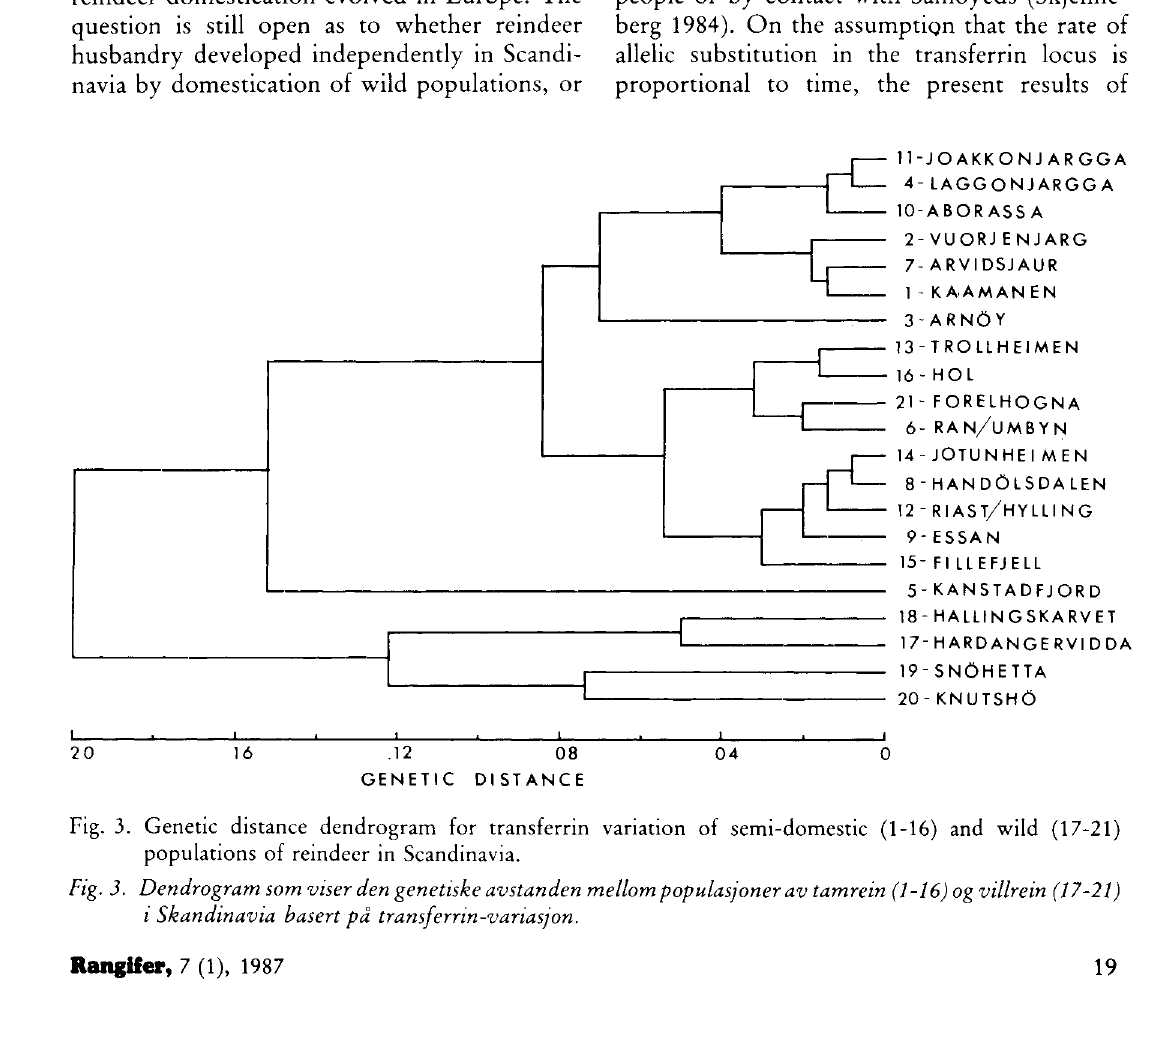
Fig. 3. Genetic distance dendrogram for transferrin variation of semi-domestic (1-16) and wild (17-21) populations of reindeer in Scandinavia. Fig. 3. Dendrogram som viser den genetiske avstanden mellom populasjoner av tamrein (1-16) og villrein (17-21) i Skandinavia basert på